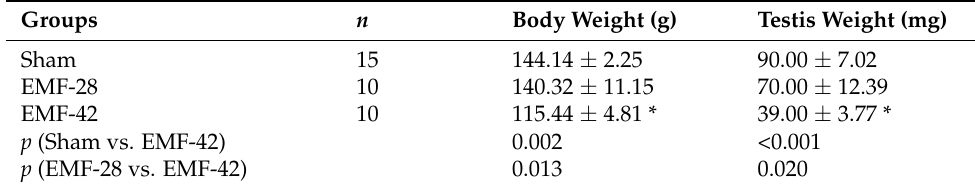
Table 1. Body and organ weights of male rat pups (mean ±